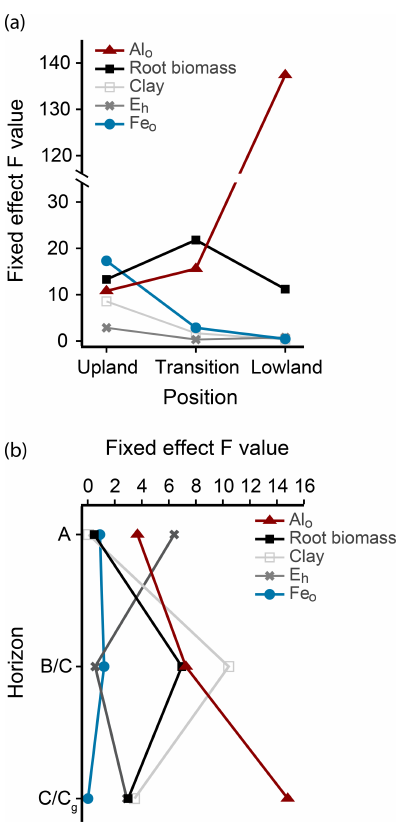
Figure 4. Fixed-effect parameters predicting total C in linear mixed-effects models. (a) F values of fixed effects for Al o , Fe o , clay, root biomass, and mean growing season E h in each land- scape position. (b) F values of fixed effects for Al o , Fe o , clay, root biomass, and mean growing season E h in the different